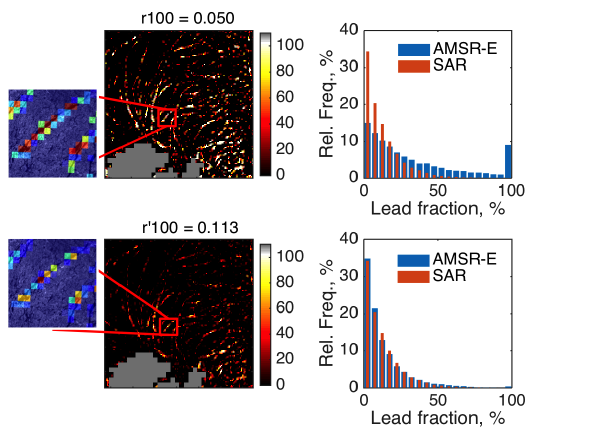
Figure 9. Adjustment of the upper tie point ( r 100 ) of the AMSR-E- based method. Upper panels: a subset of lead fraction (LF) values located in the area of interest (Fig. 2) (left) and distribution cal- culated from the full LF map (entire Arctic) on the 8 March 2009 (right, blue bars). The original r 100 value is used. The orange bars show the SAR LF distribution for the whole month of March 2009 for reference. Bottom panels: same, but for the adjusted r (cid:48) 100.